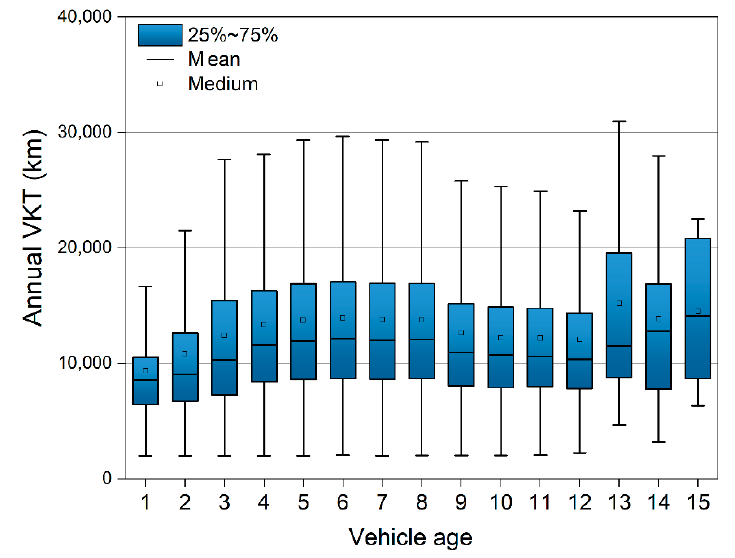
Figure 3. Annual VKT trend from 4S stores in 2019.